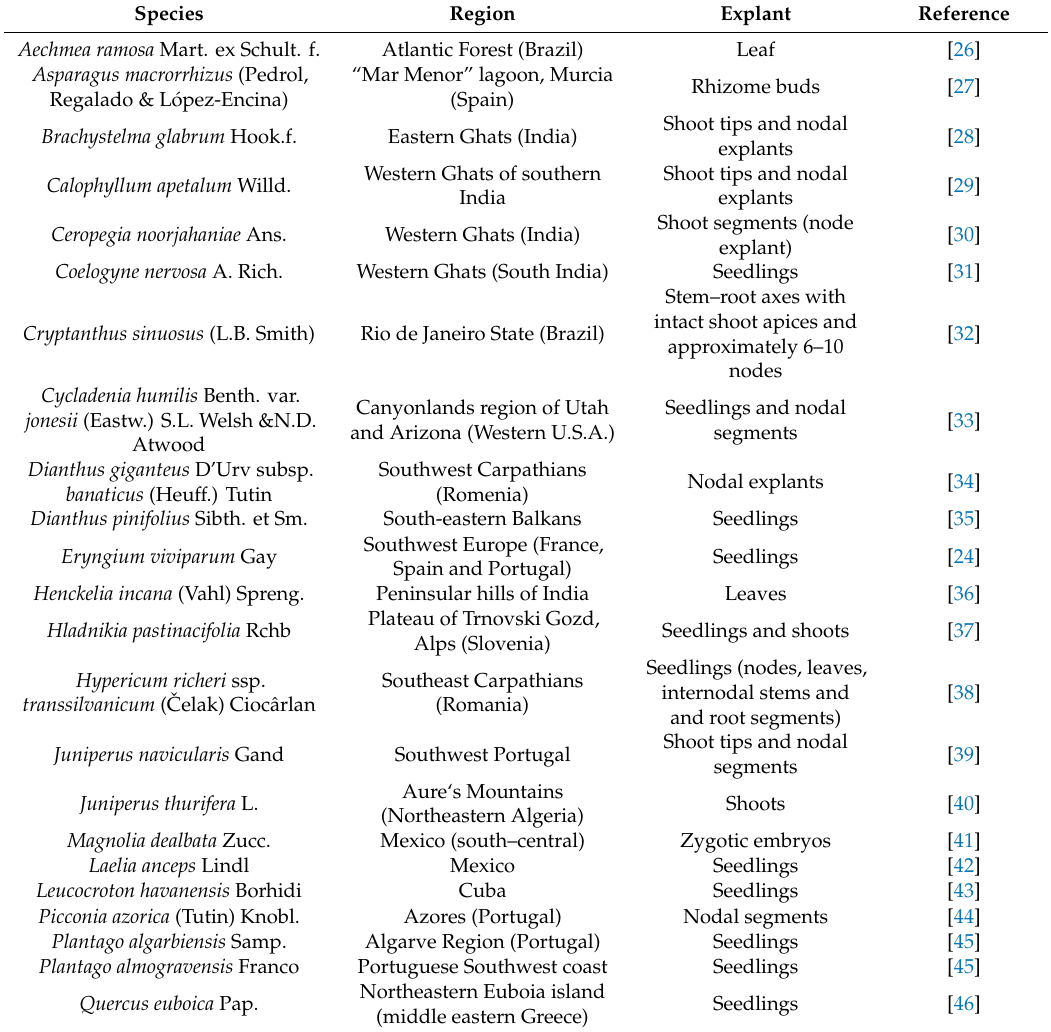
Table 1. Selected scientific publications on micropropagation of endemic plant species, including the name of the species, the region of distribution, and the explant type. Species Region